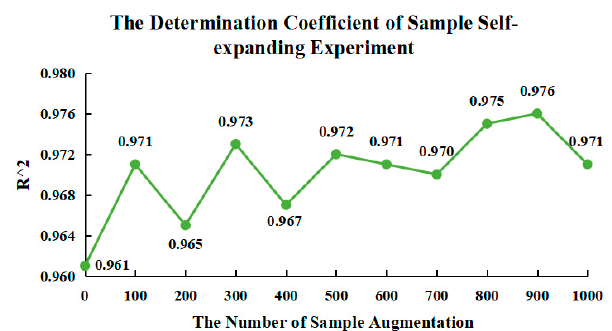
Figure 7. R 2 of the results for various numbers of self-expanding samples.